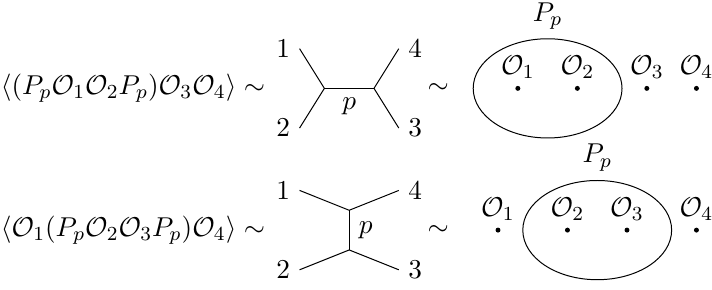
Figure 2 . Inserting projection operators P p onto the Verma module of a primary O p into a correlator yields the conformal block with internal weight h